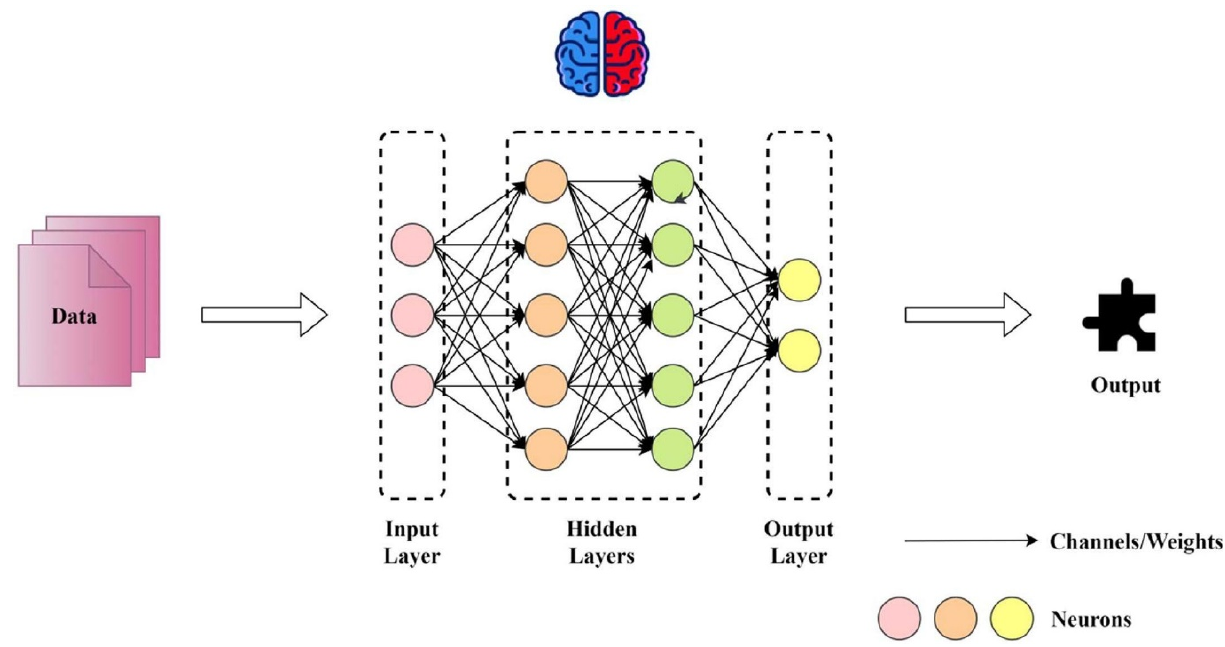
Figure 7. Schematic diagram of an ANN [89] .